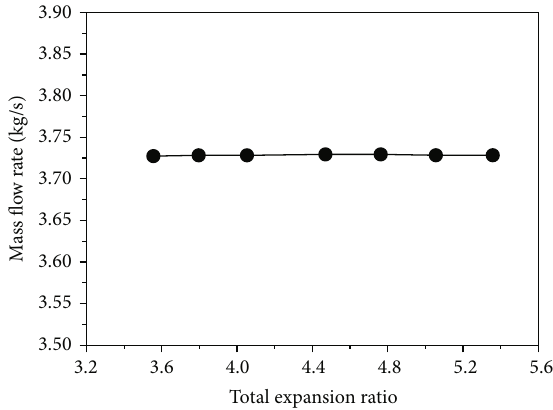
Figure 14: Mass fl ow characteristics at design speed.